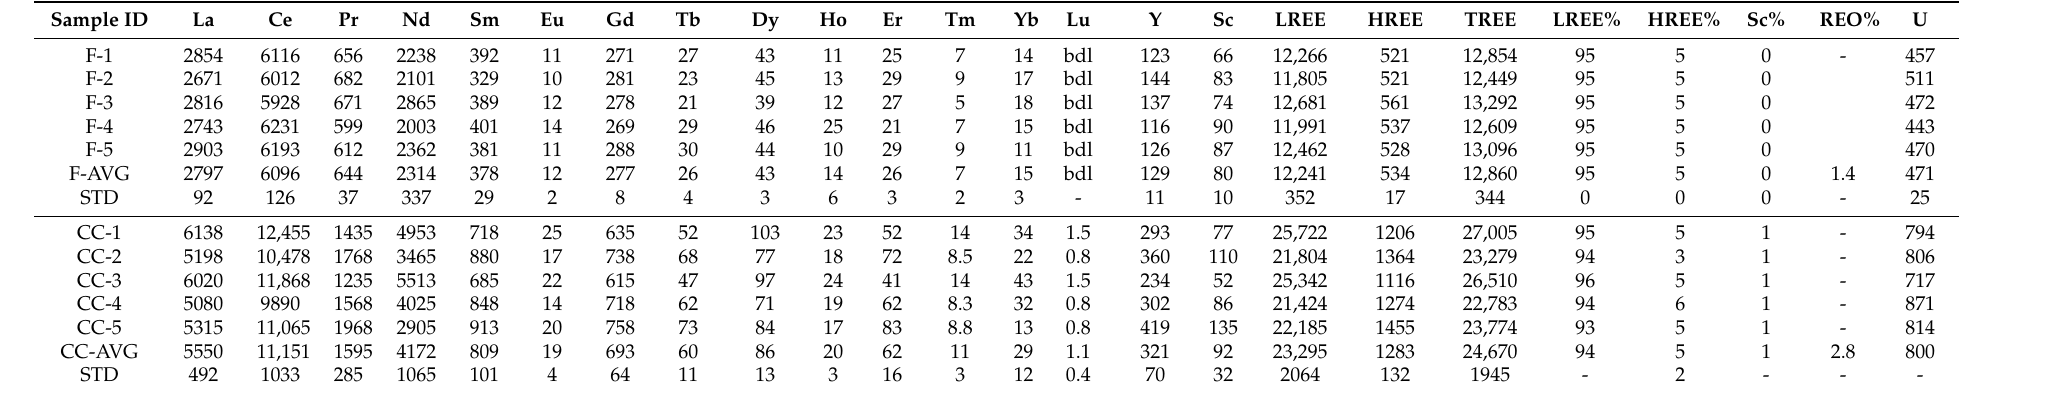
Table 2. REE and U concentrations (mg/kg) of feed (F) and concentrated (CC) samples. (bdl—below the detection limit, AVG—average, SD—standard